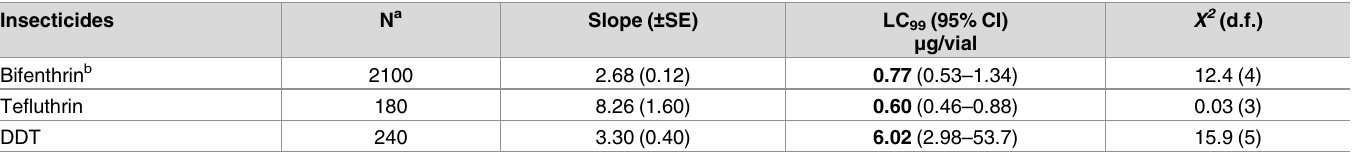
Table 1. Baseline susceptibility and diagnostic concentration (LC 99 ) ( ± 95% confidence interval) of western corn rootworm adults by contact to bifenthrin, tefluthrin, and DDT generated from laboratory colonies.